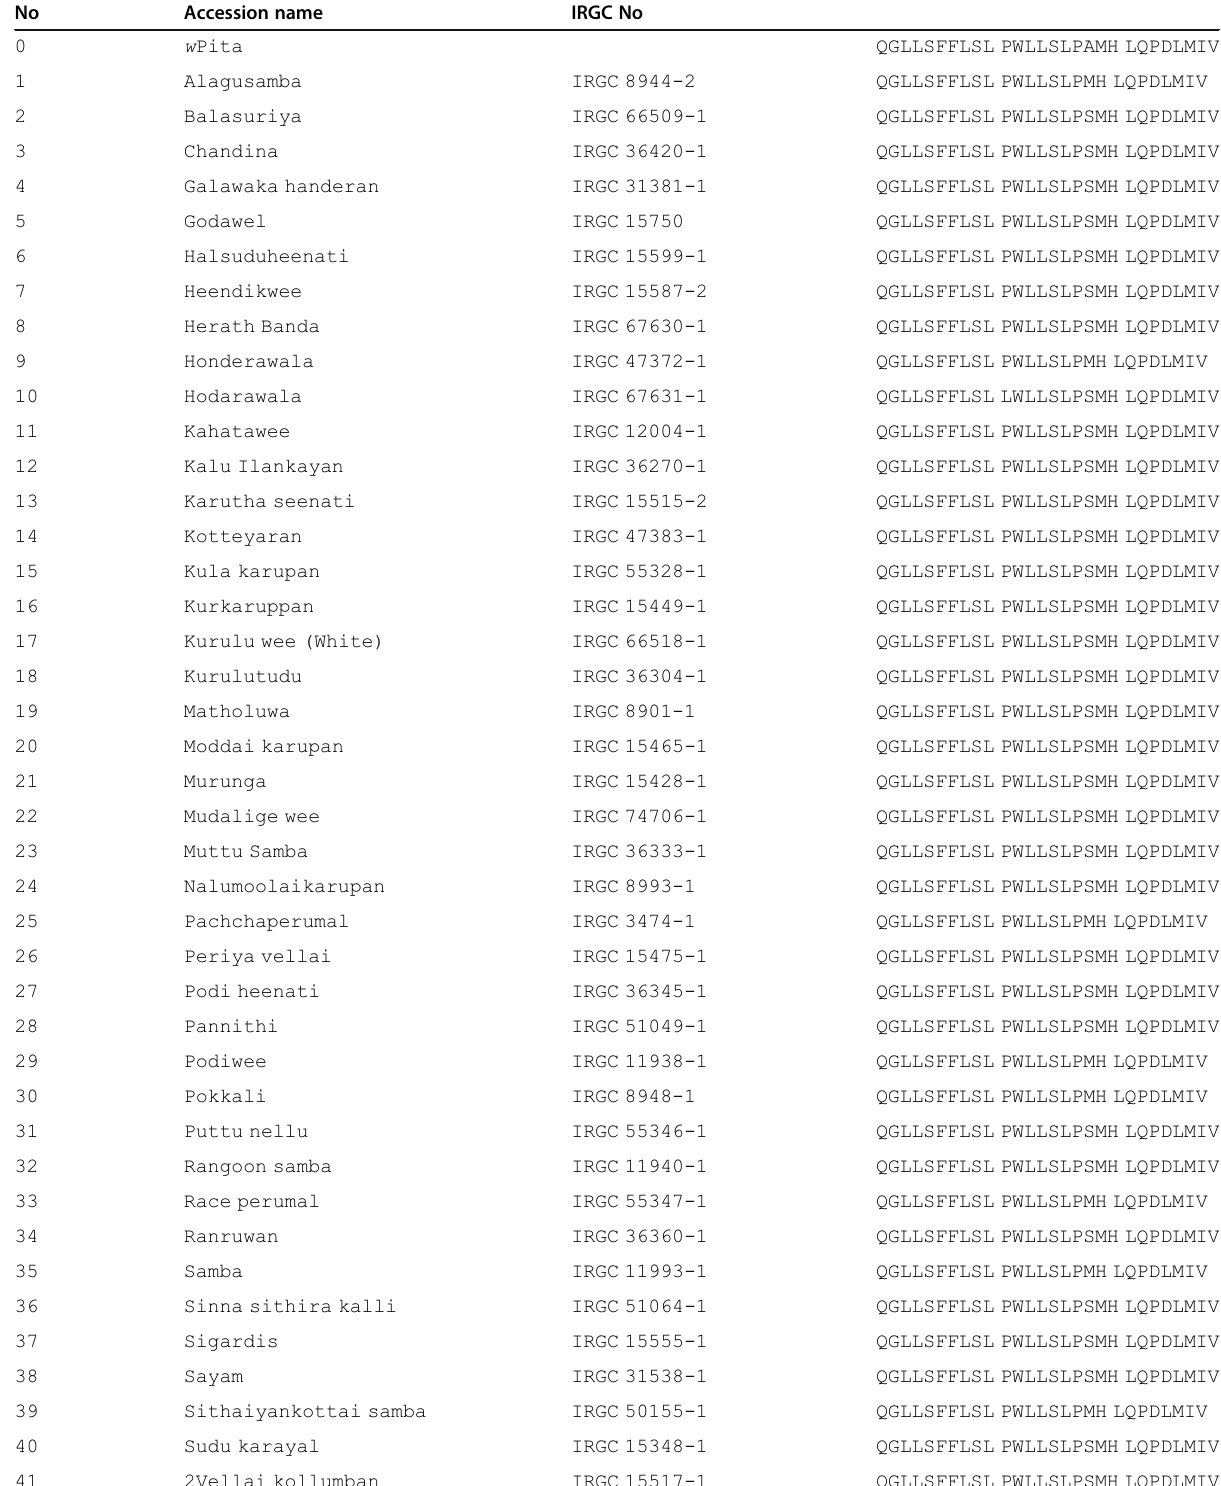
Table 2 Comparison of Pi-ta protein sequences of 47 Sri Lankan rice accessions with wPi-ta ( Tetep , GenBank accession number GQ918486.1) using Clustal W, Bioedit 7.2.5. Highlighted in black are the amino acids that contributed to the resistant phenotype due to the absence of the functional mutation at the 918th amino acid